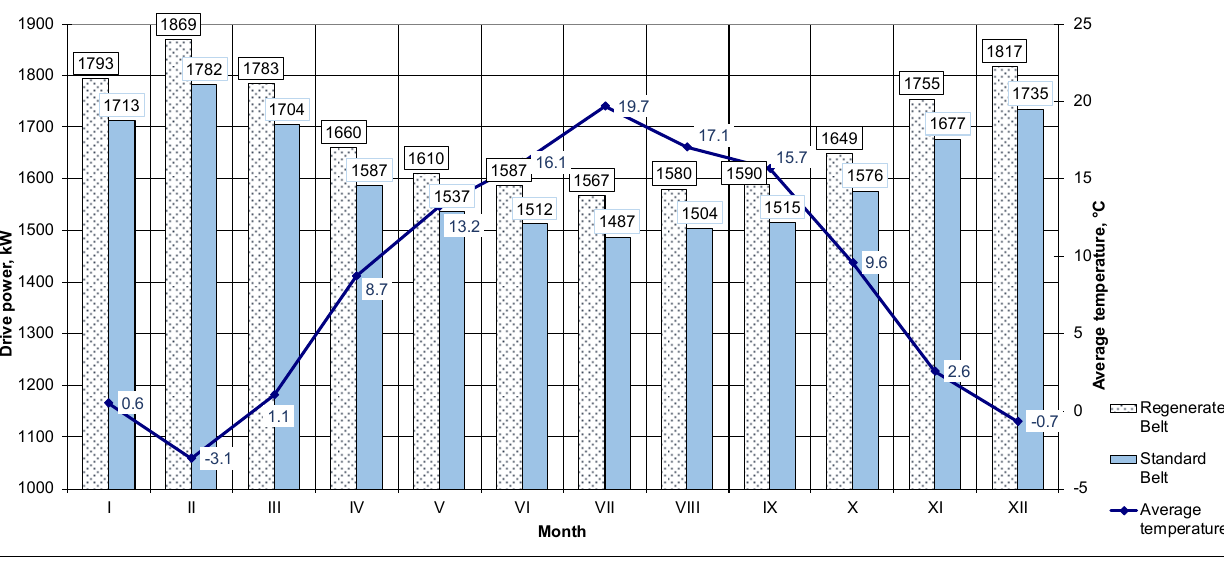
Figure 6. Relationship between power consumption and mean monthly temperatures for the 1-ST standard belt and for the 1-ST-R1 refurbished belt.